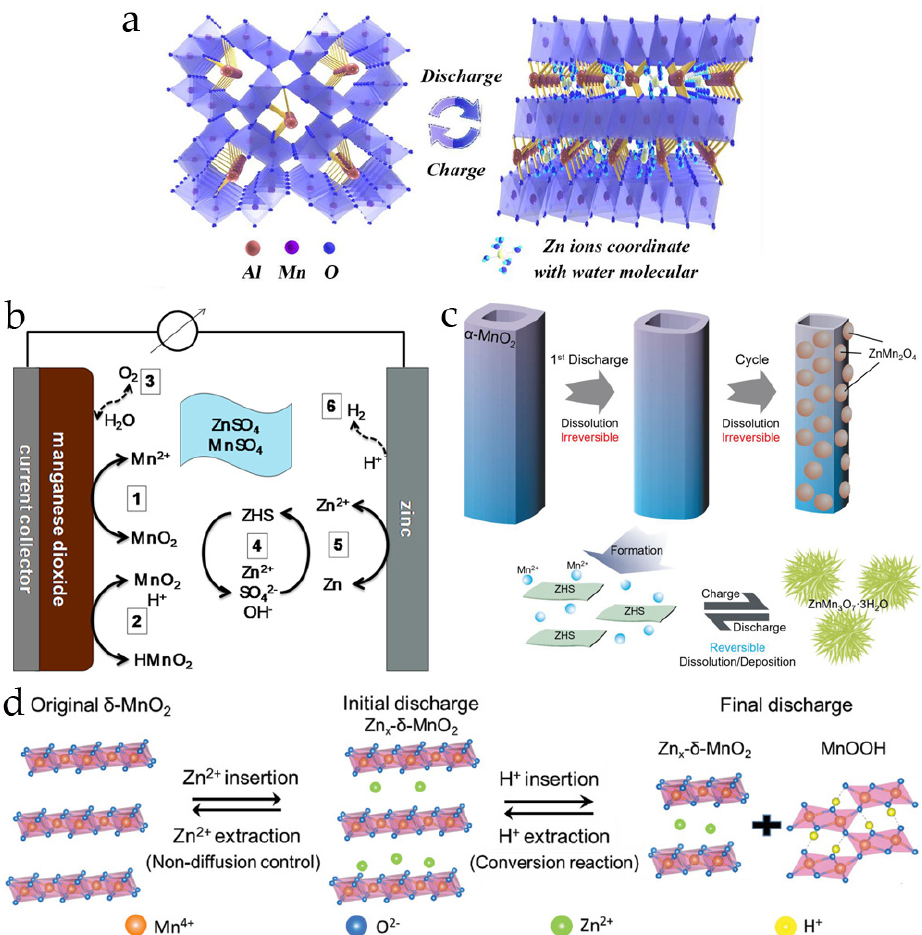
Figure 13. ( a ) Scheme of phase transitions in Al-doped MnO 2 material with Zn 2+ ions reversible intercalation [24]. ( b ) Summary of the chemical processes in the AZIB with a Zn/ZnSO 4 +MnSO 4 /MnO 2 cell: (1) Mn 2+ deposition/MnO 2 dissolution, (2) H + (de-)intercalation, (3) OER/ORR, (4) ZHS precipitation/dissolution, (5) zinc plating/stripping, and (6) HER [103]. ( c ) Schematic illustration of the reaction mechanism of α -MnO 2 in AZIBs with the dissolution/deposition mechanism [107]. ( d ) Joint non-diffusion controlled Zn 2+ intercalation and H + conversion reaction mechanism in δ -MnO 2 [108].